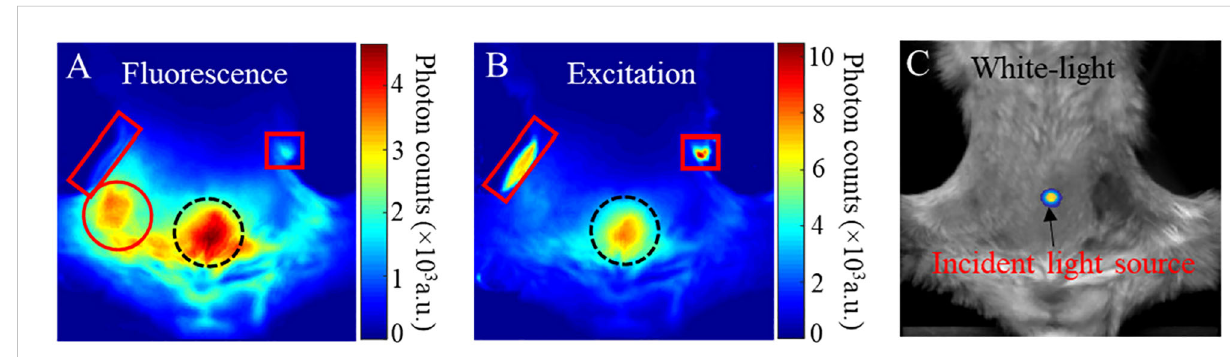
FIGURE 3 (A) Fluorescence image; red circle tumor signal, dotted circle gut uptake signal, left rectangle fi lter leakage animal holder signal, and right rectangle fi lter leakage mouse fur signal (B) Excitation image; Dotted circle gut excitation signal, right rectangle mouse fur re fl ection signal, left rectangle animal holder re fl ected signal. (C) white-light images of a mouse bearing a 4T1 tumor and received PLGA-anti-EGFR nanoparticle injection. The trans-illuminating point light source is overlapped onto (C) , to indicate the light-source